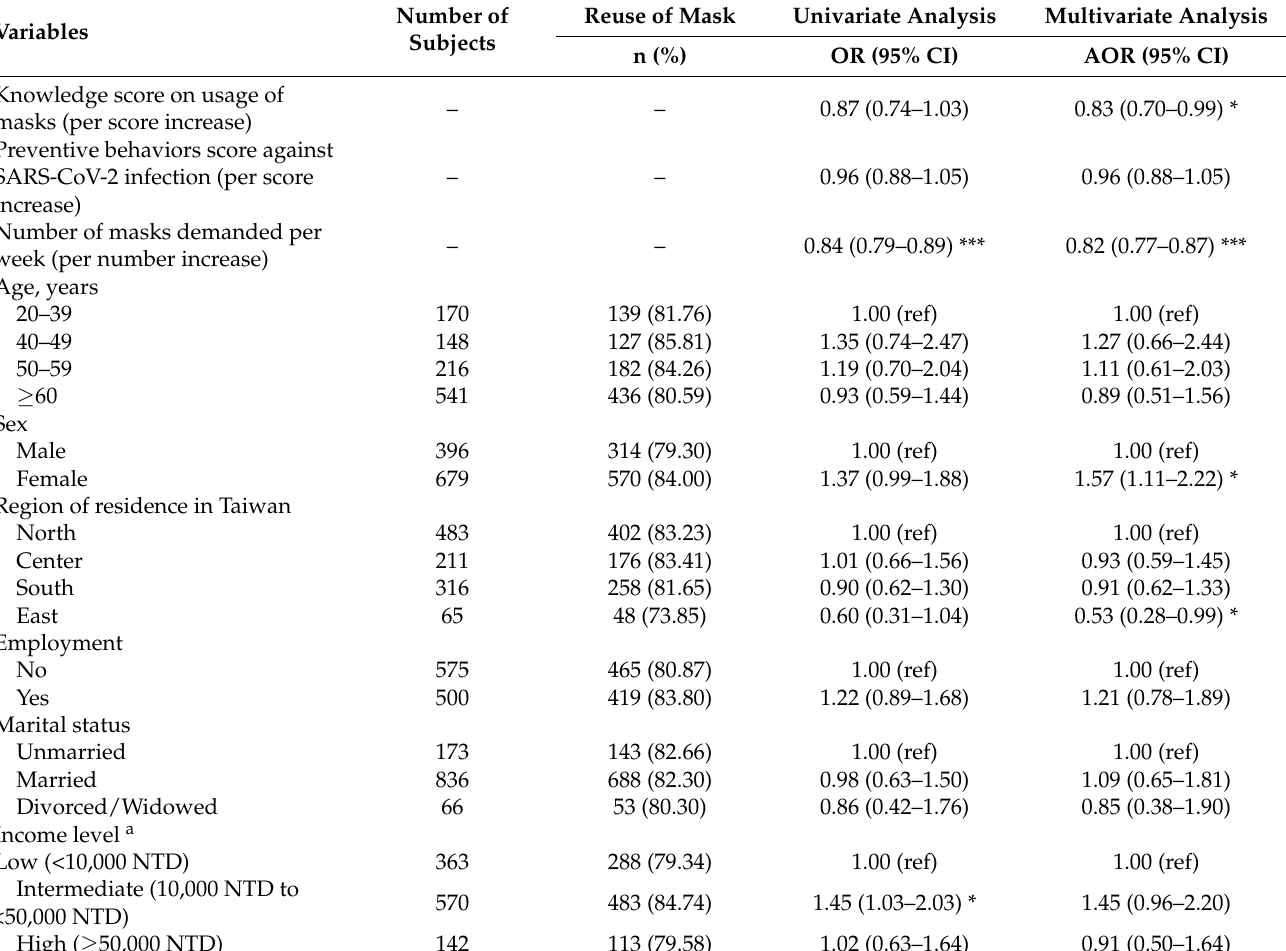
Table 2. Univariate and multivariate analyses of factors associated with the reuse of masks during the COVID-19 pandemic in Taiwan ( N =